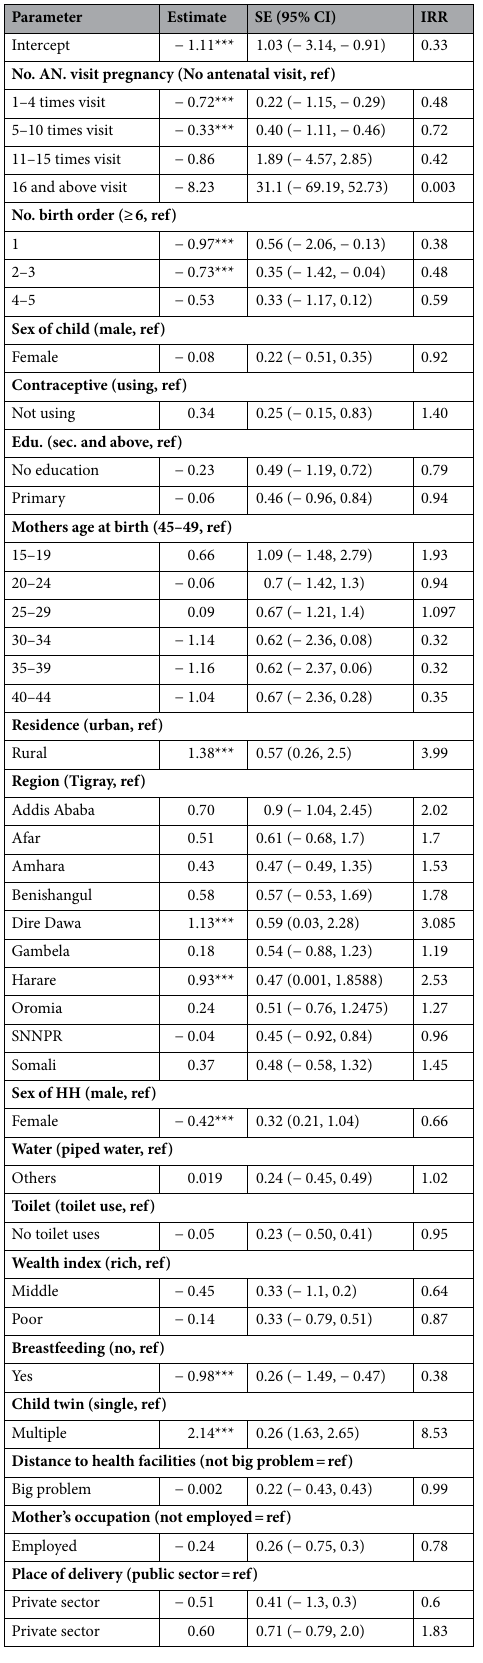
Table 7. Parameter estimates for the ZINB model for the count